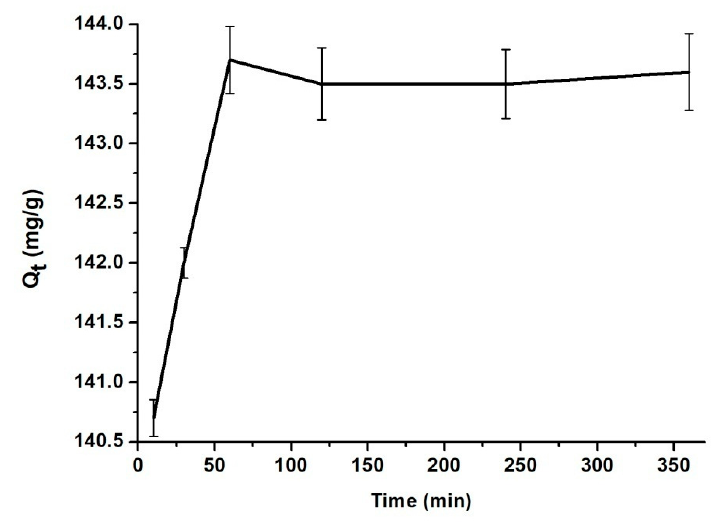
Figure 4. The influence of the contact time of BZC with MSN.